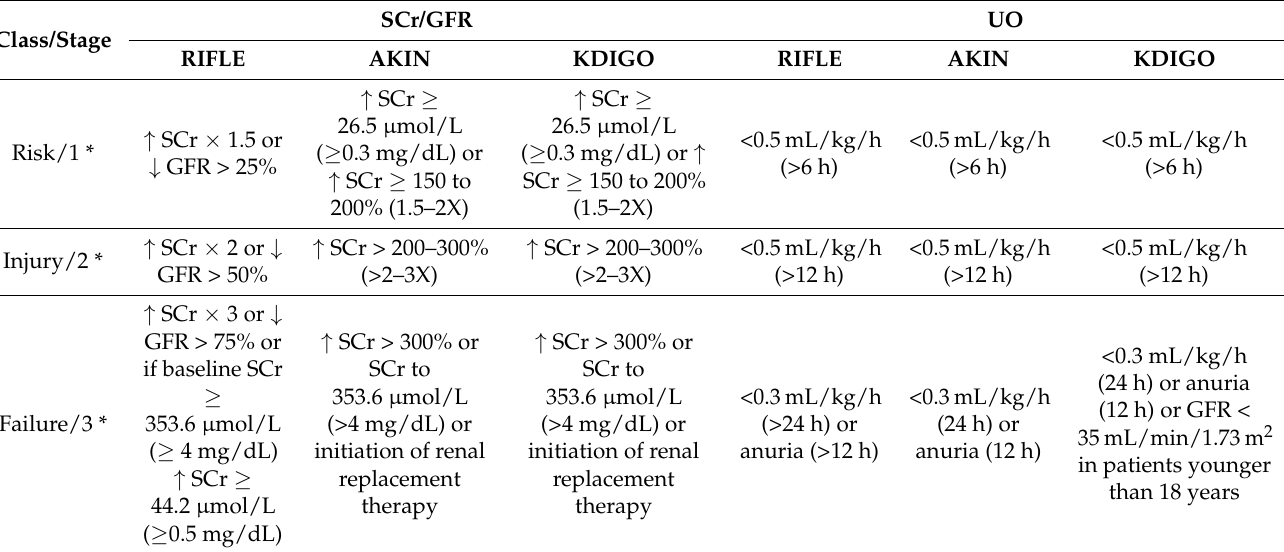
Table 1. Classifications of acute kidney injury (per guideline recommendations) [7,8,13,14]. Table adapted with permission from Gameiro, J.; Agapito Fonseca, J., Jorge, S. et al., 2018 [13].